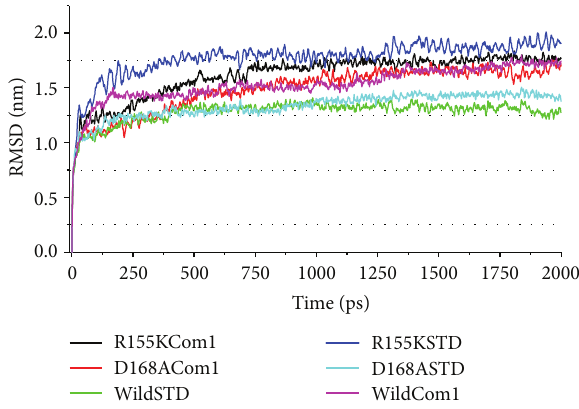
Figure 6: Protein backbone RMSD calculation plots for ligand bound complexes. Asunaprevir perturbs backbone of the protein mutant R155K (curve in blue) more than Andrographolide (curve in black). Surprisingly, Andrographolide seems to disturb protein structure for the mutant D168A more than Asunaprevir (check cyan curve for Asunaprevir and red for Andrographolide). (Note: Asunaprevir is mentioned as STD and Andrographolide as Com 1.)